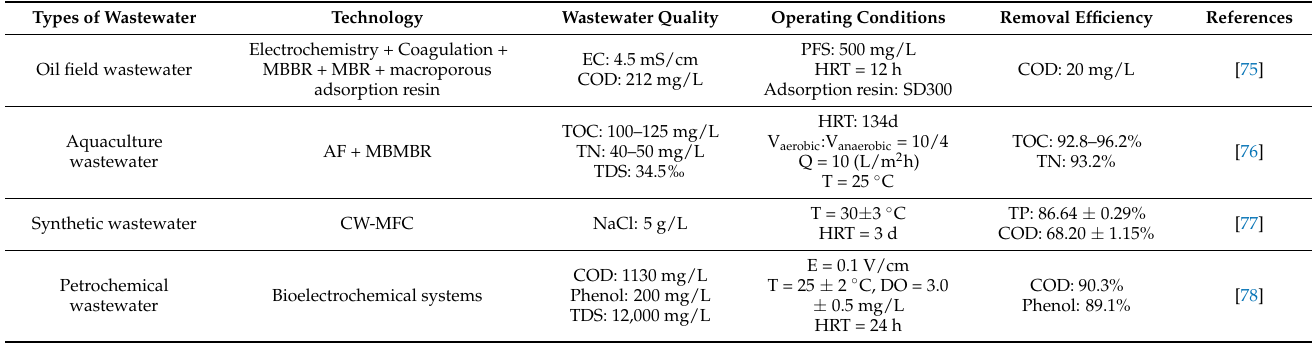
Table 9. Performance and experimental conditions of hybrid treatment processes for the treatment of saline